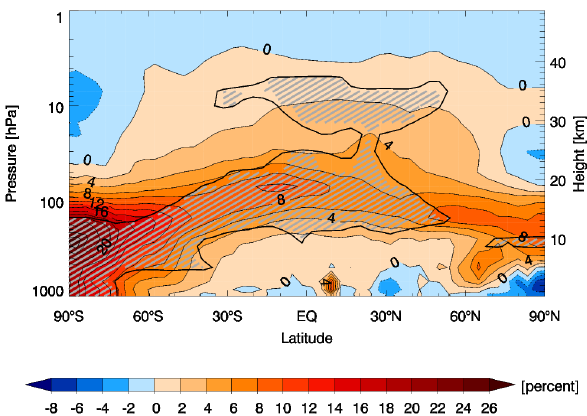
Fig. 2. Annual mean effect of GCRs on zonal mean NO x , ([NO x ] GCR -[NO x ] control ) /[NO x ] control , in percent ([NO x ]=[NO] + [NO 2 ]). Results are averaged from 1978–2002 (after allowing for a 2-year model spin-up) with appropriate accounting for solar minimum and maximum periods. Solid contours indicate positive, dotted contours negative changes. Hatched areas (enclosed by solid contours) indicate changes with at least 95% statistical significance.